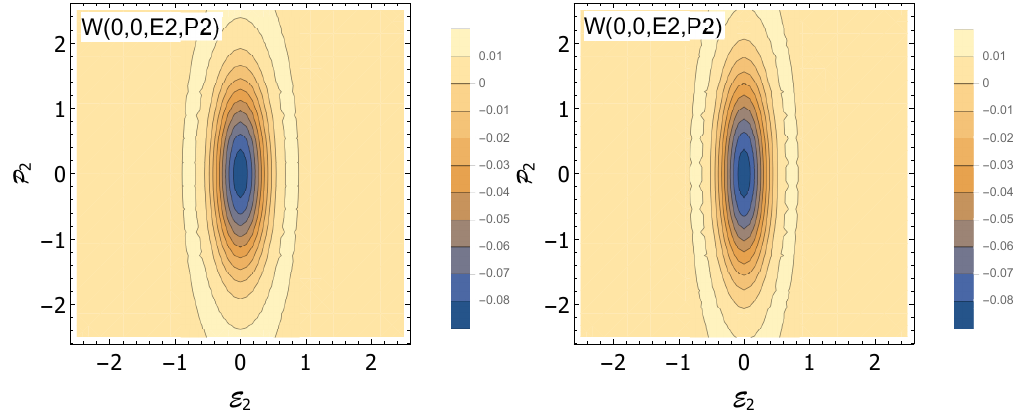
Figure 6. Comparison of the Wigner functions related to quantum vortices obtained by APD heralding ( left ) and a superposition of ideal Wigner functions for the first two vortex orders ( right ). Left : plot of the Wigner distribution on the phase space W E (cid:48) for a quantum vortex with squeezing factor s = 0.7, weakly couplers transmission t = 0.85 and ideal transmission and heralding ( η = 1, ν = 1, ζ = 1). Right : superposition of Wigner functions for ideal quantum vortices of orders n = 1 and 2: 0.91 W 1 + + 0.07 W 2 +